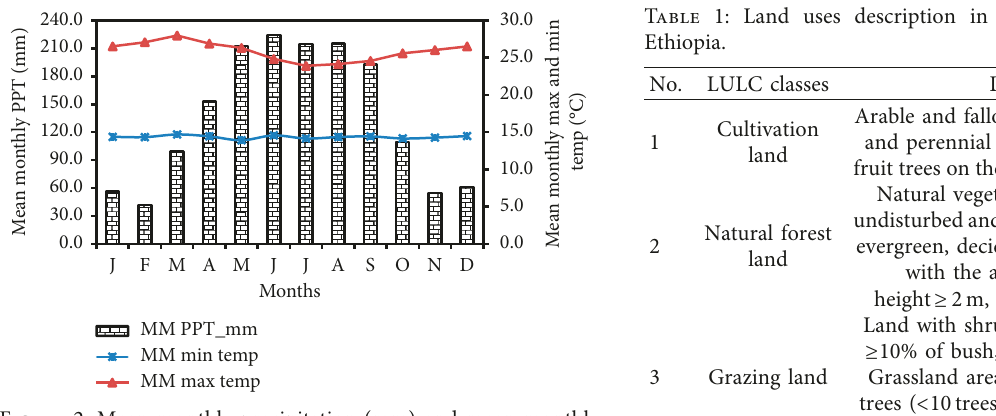
Figure 2: Mean monthly precipitation (mm) and mean monthly maximum and minimum temperature ( ° C) at Dirri meteorological station, Geshy subcatchment [34].